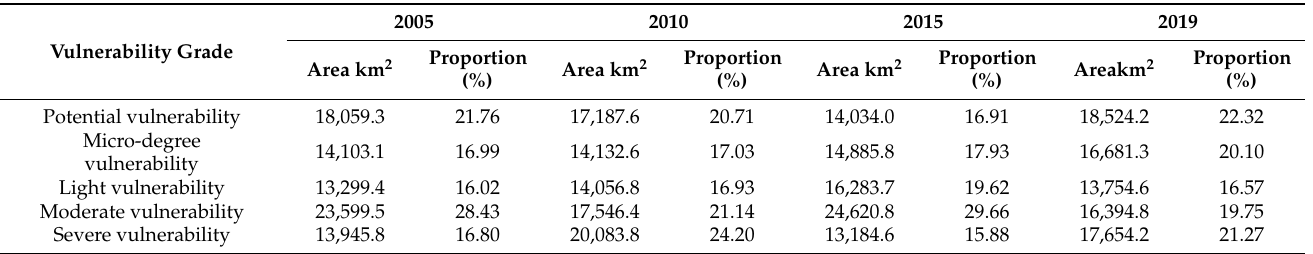
Figure 7. Spatial distribution of socio-ecological vulnerability in Aba Prefecture, 2005–2019. Table 8. Areas and proportions of the socio-ecological vulnerability grades in Aba Prefecture,